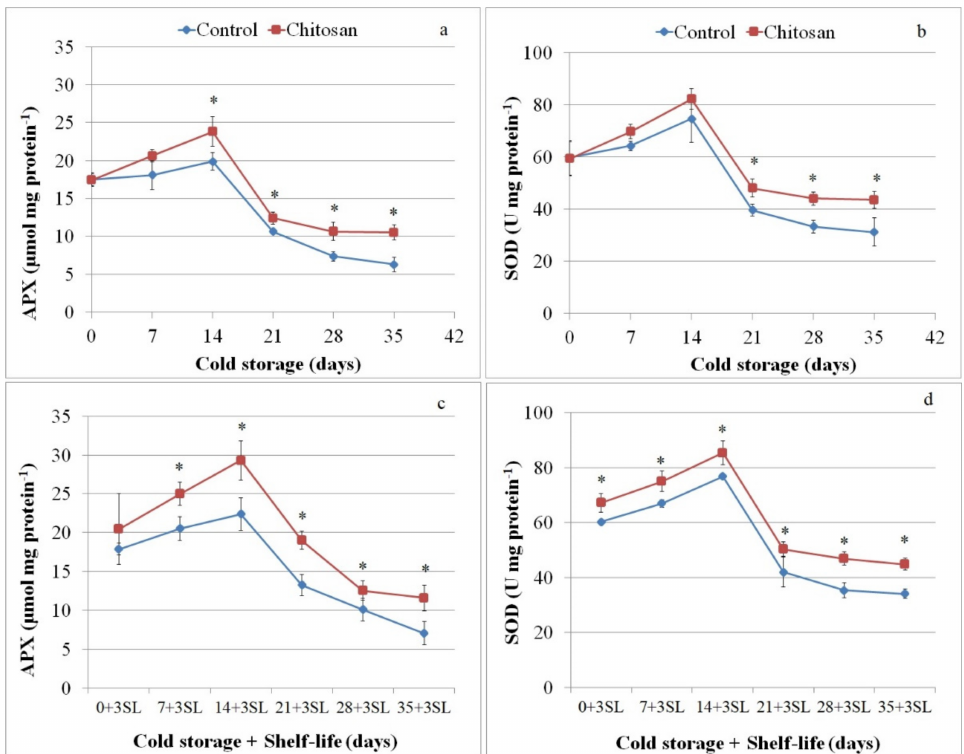
Figure 2. Ascorbate peroxidase (APX; µ mol ascorbate per mg protein activity) and superoxide dismutase (SOD, U per mg protein) at harvest (0) and after 7, 14, 21, 28 and 35 days of cold storage ( a , b ) followed by 3 days of shelf life ( c , d ) for chitosan-coated (Chitosan) and uncoated fruit (Control). One asterisk (*) indicates p value smaller than 0.05 ( p <